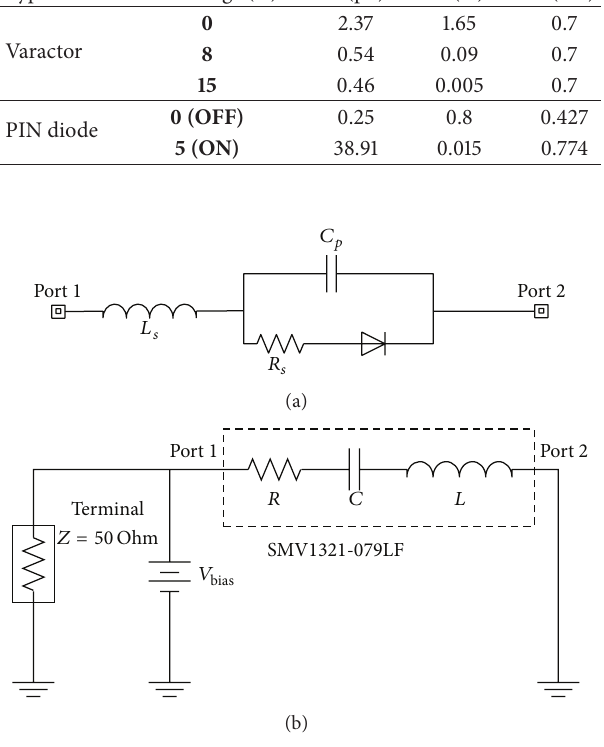
Figure 2: Extraction of effective parameters of the PIN diode and the varactor: (a) the spice model of the varactor; (b) circuit model of extraction, which is used to extract the effective circuit parameters of the varactor based on its spice model.